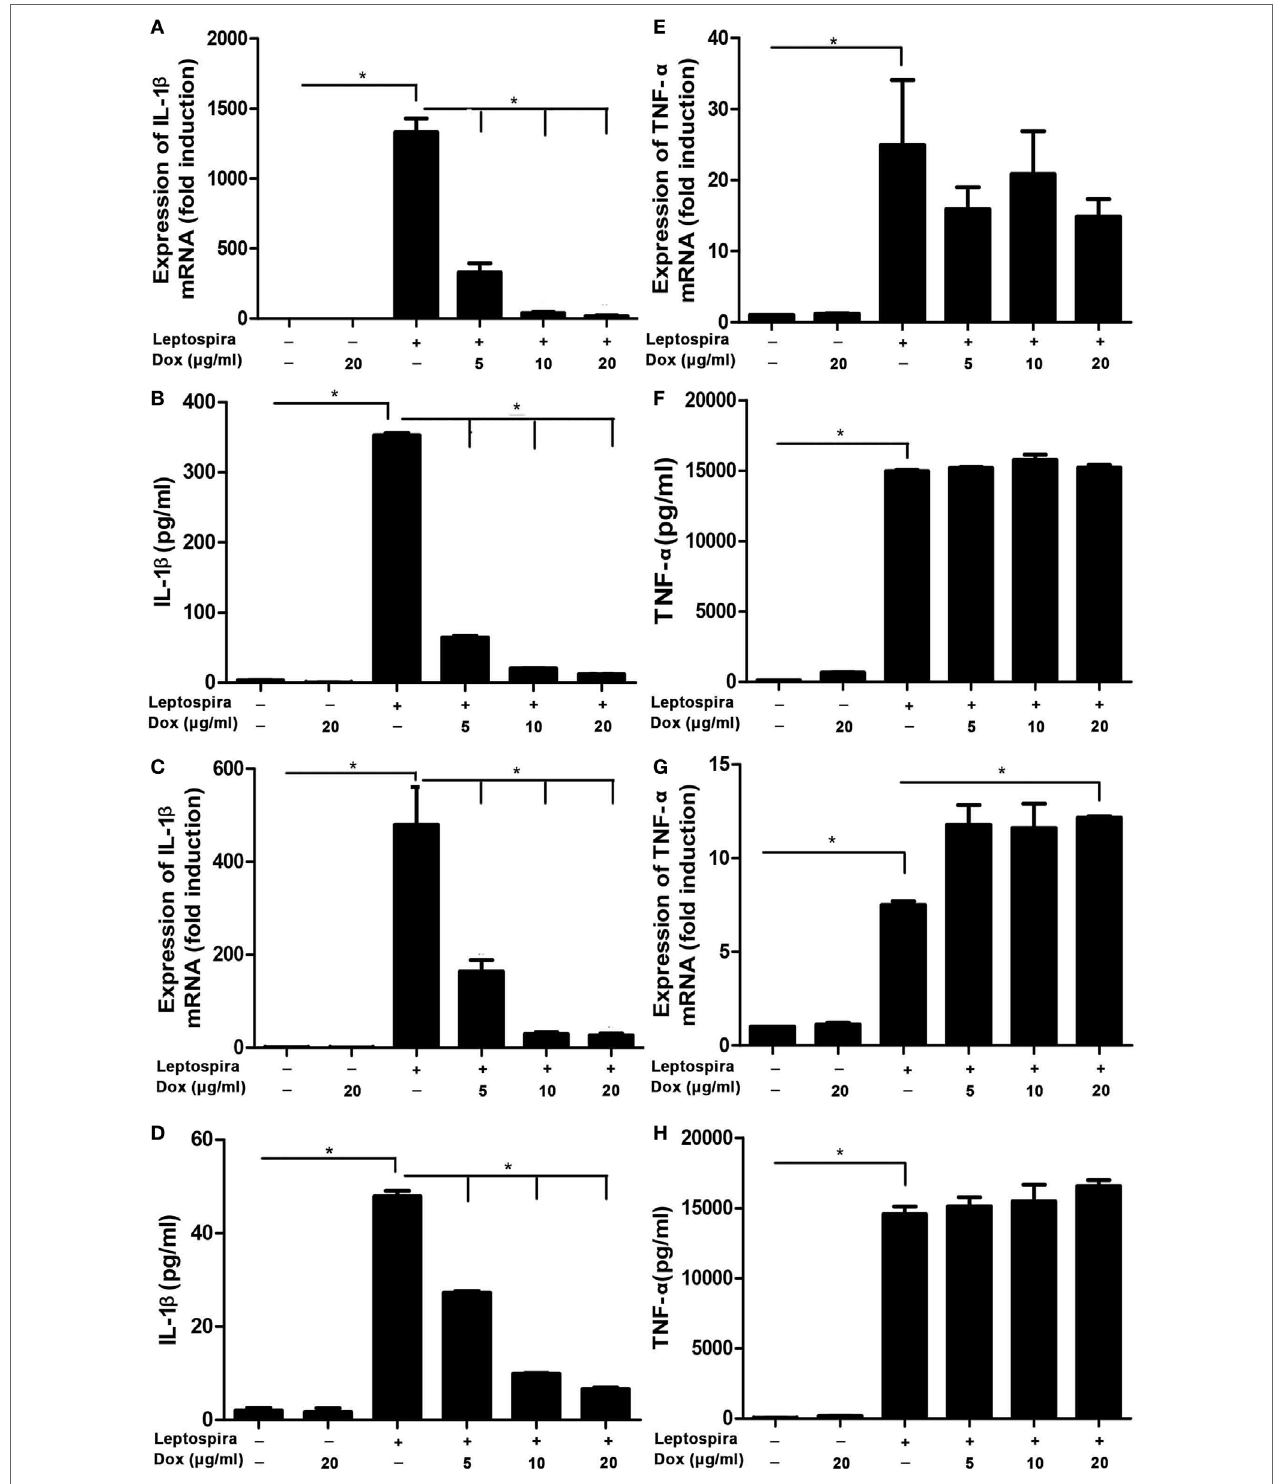
FigUre 1 | Doxycycline inhibited leptospira-induced IL-1 β mRNA and protein levels in J774A.1 cells. The level of mRNA of IL-1 β and TNF- α was analyzed by quantitative real-time polymerase chain reaction and the protein level in supernatant (Sup) was analyzed by enzyme-linked immunosorbent assay (ELISA). (a,B,e,F) Cells were infected by live leptospira. (c,D,g,h) Cells were infected by sonicated leptospira. The mRNA levels of IL-1 β (a,c) and TNF- α (e,g) were normalized to the expression of the housekeeping gene GAPDH. The mRNA levels of cytokines in untreated controls were set as 1.0. The protein levels of IL-1 β (B,D) , and TNF- α (F,h) in Sup were measured by ELISA. Bars show the levels of cytokines with mean ± SD ( n = 3) and analyzed by the one-way ANOVA. * p <